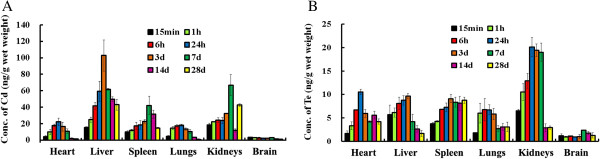
Bio-distribution of Cd (A) and Te (B) in mice exposed to CdTe/ZnS aqQDs. ICR mice were injected via tail vein with CdTe/ZnS aqQDs (0.2 μmol/kg). Serial sacrifices were carried out at 15 min, 1 h, 6 h, 24 h, 3 d, 7 d, 14 d, and 28 d after dosing. Several organs/tissues, including heart, liver, spleen, lungs, kidneys, and brain were isolated to determine concentrations of Cd and Te with ICP-MS. The mean values of the control were deducted as the baseline (Additional file 2: Table S2). All data are represented as the mean ± SD, n = 6.